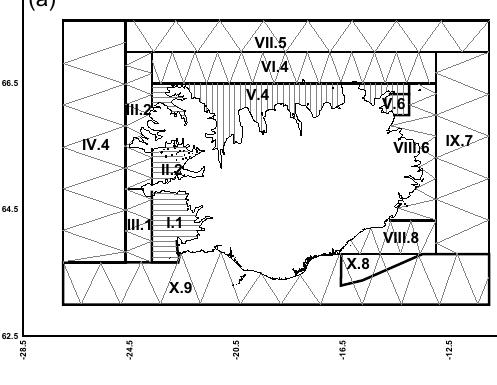
Fig. 1. Survey plans, showing block definitions (numbers) and planned tracklines for a) 1986 and b) 2001. For 1986, the original block numbers